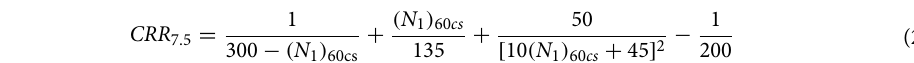
where, CSR is cyclic stress ratio, a max is peak horizontal acceleration, g is acceleration of gravity, σ v is vertical ′ total stress, σ v is vertical effective stress, γ d is stress reduction coefficient, MSF is magnitude scale factor. CRR is cyclic resistance ratio. When CSR > CRR, the soil layer is judged to be liquefied; otherwise, it is judged to be non-liquefied. Rauch (1996) proposed a formula to calculate CRR: